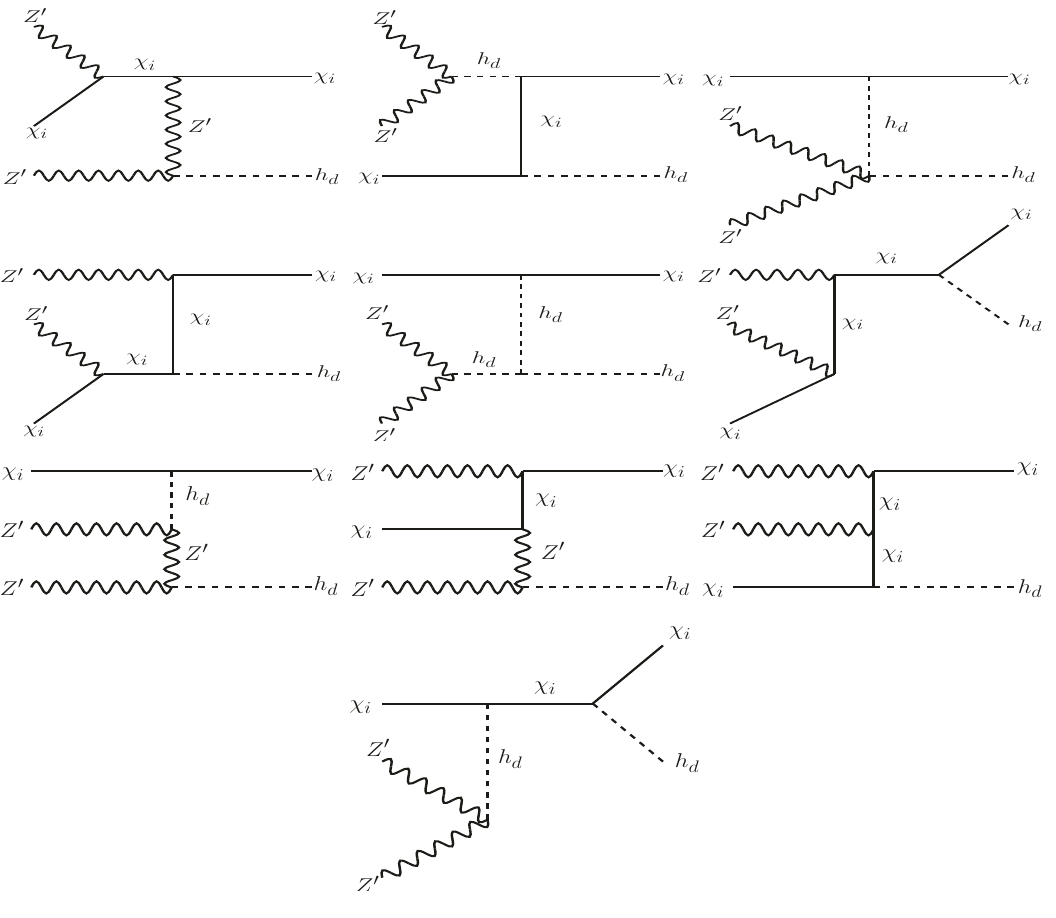
Z 0 Z 0 → χ h d i i